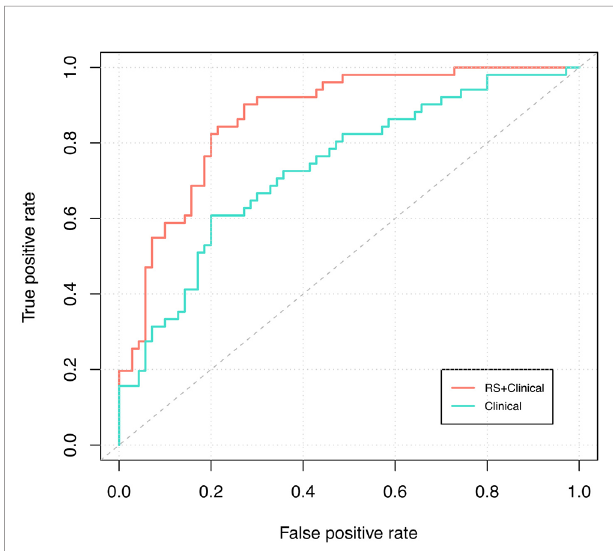
FIGURE 3 | ROC curve analysis. Receiver-operating-characteristic cuve analysis of the two models indicating their ability to discriminate between pCR and non-pCR patients. The blue line represents the ROC curve of the clinical model and the corrected AUC is 0.70; the red line represents the ROC curve of the RS+clinical model and the corrected AUC is